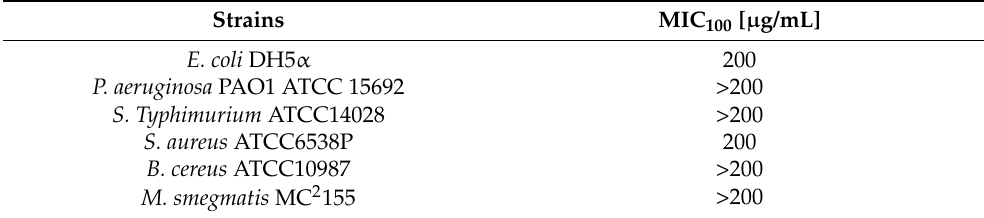
Table 2. Determination of minimum concentration values (MIC) inhibiting bacterial growth. The MIC 100 is expressed in µ g/mL of C. aurantium ‘Crispifolia’ EO against the indicator strains. The values were obtained from a minimum of three independent